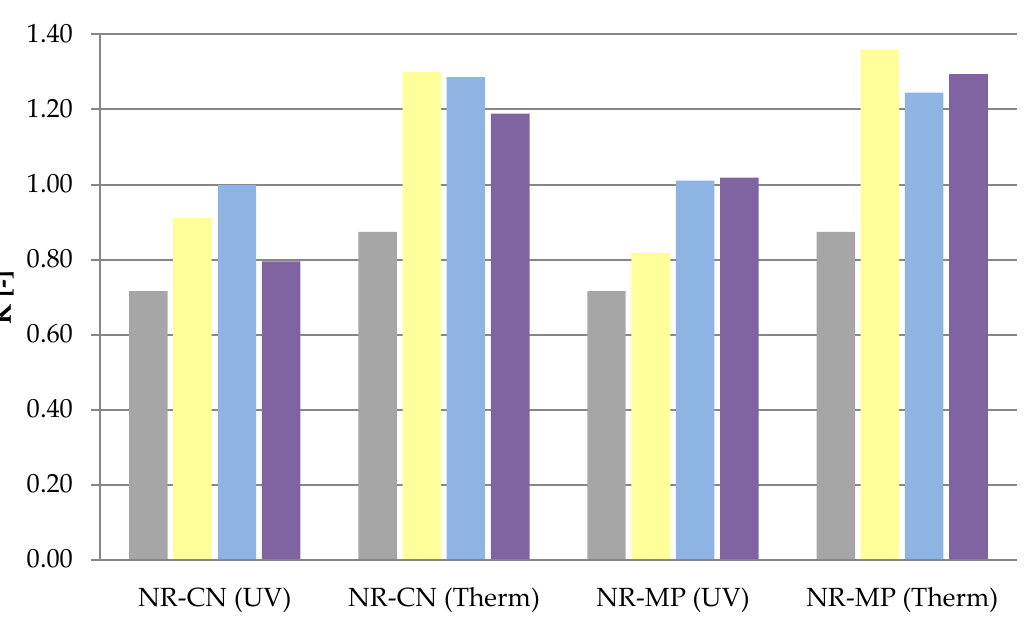
Figure 11. Aging factor (K) of samples after ultraviolet (UV) and thermo-oxidative (Therm) aging.